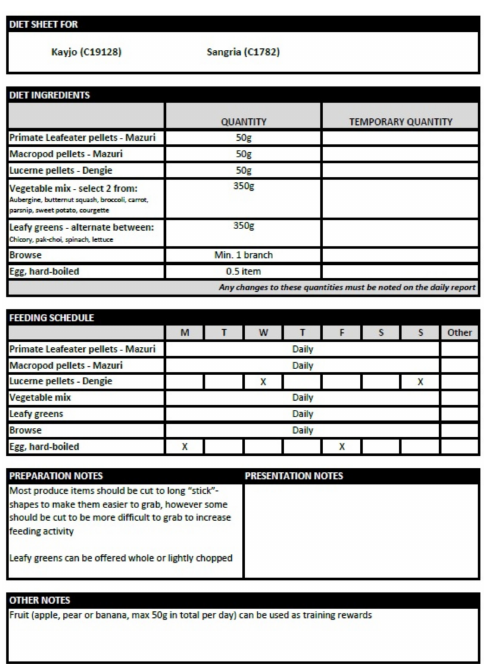
Figure A1. Diet sheet of Dendrolagus goodfellowii provided to study subjects throughout the observa- tion period. Diet quantities displayed were those provided per